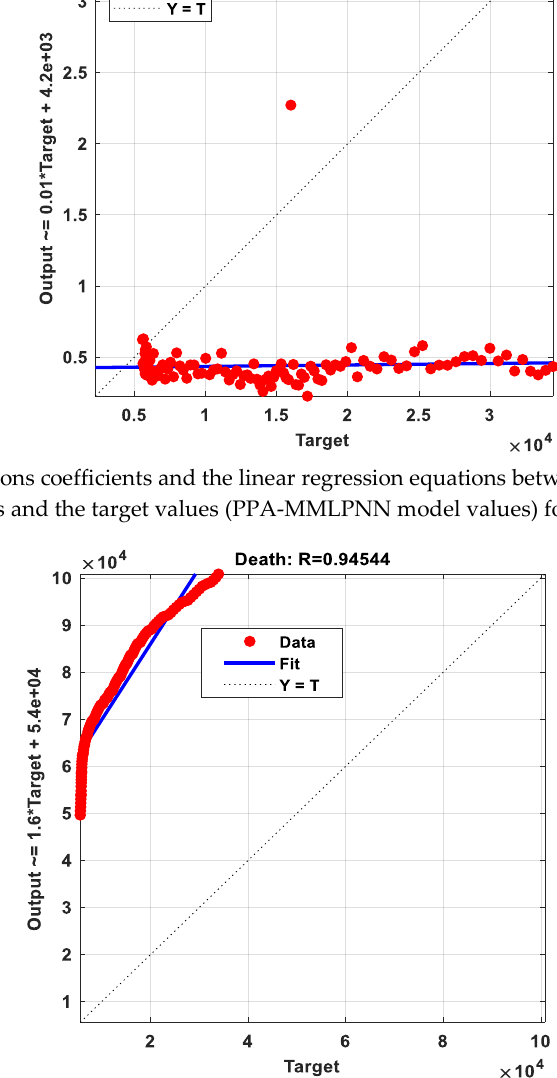
( c ) The correlations coefficients and the linear regression equations between the observed deaths values and the target values (PPA-MMLPNN model values) for Mexico. Figure 10. The correlation coefficients and the linear regression equations between the testing data of (infected, recovered and deaths) and PPA-BMLPNN model values for Mexico.